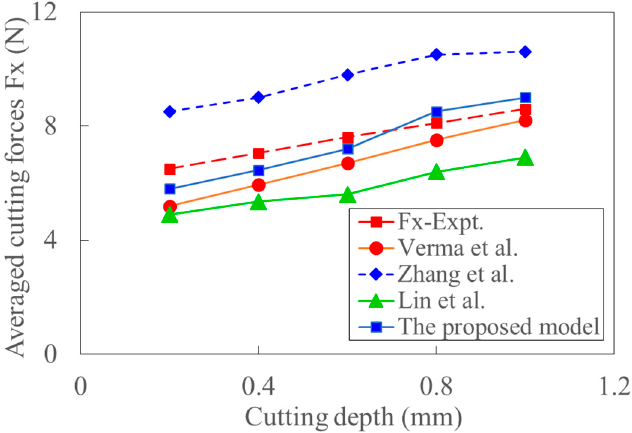
Figure 19. The comparison of predicted and experimental averaged cutting forces with the increased cutting depth (Feed rate: 50 mm/min, Amplitude: 12 um, RPM: 1875).